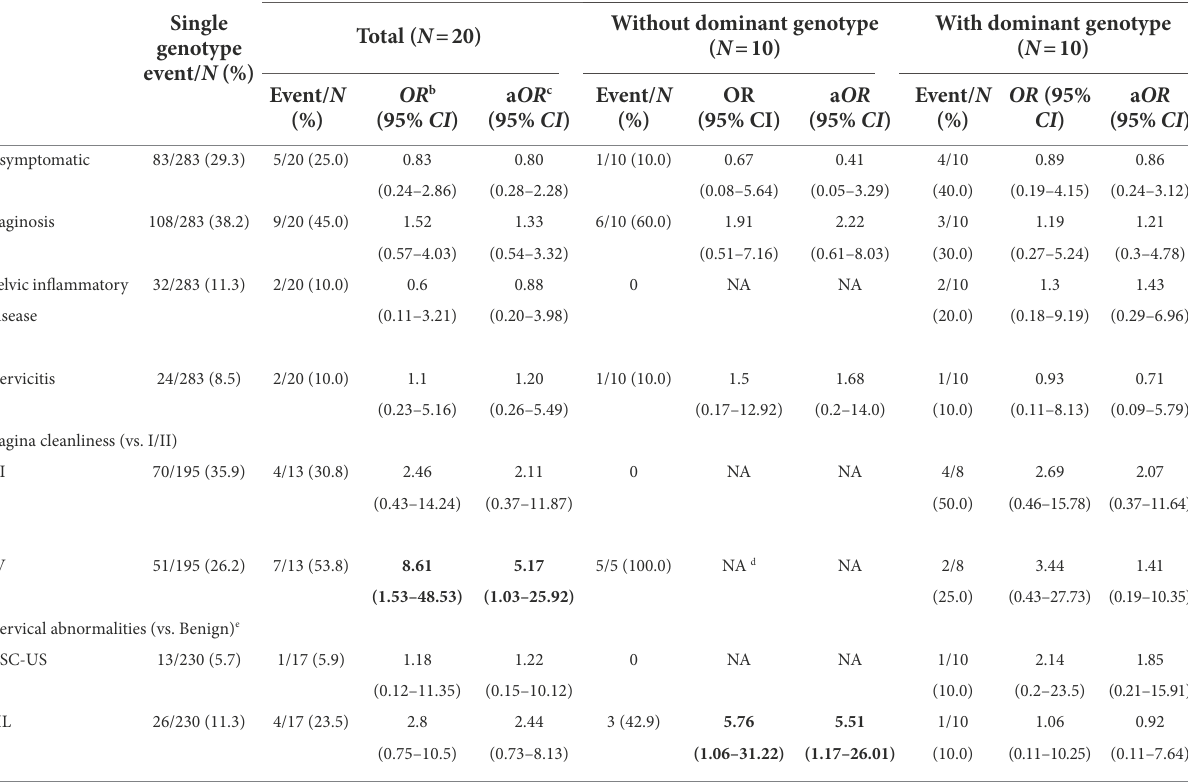
TABLE 5 Comparison of clinical manifestations between women with C. trachomatis single-genotype and mixed-genotype infections.